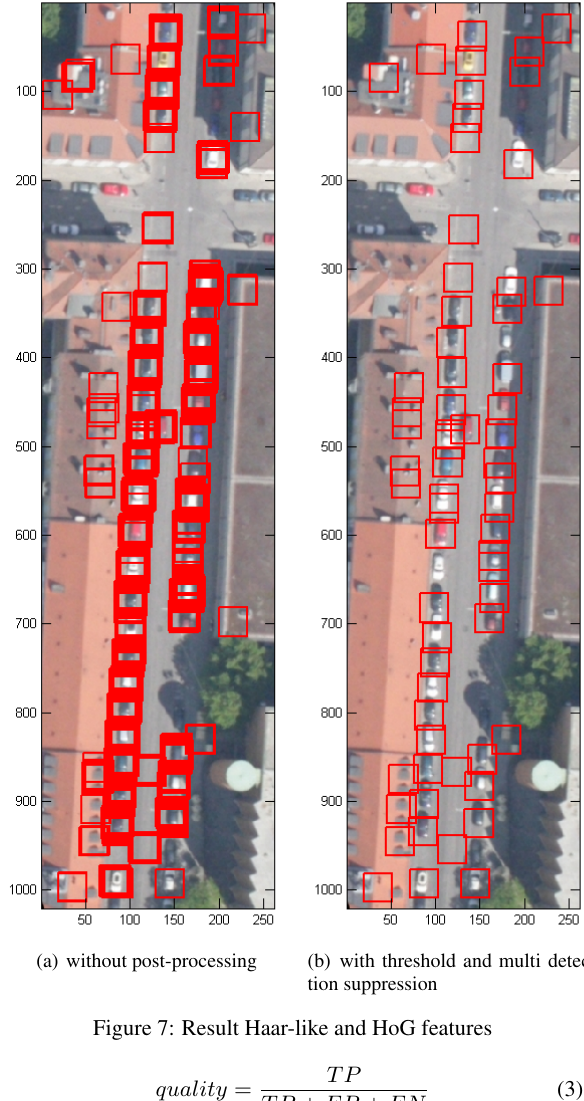
Figure 7: Result Haar-like and HoG